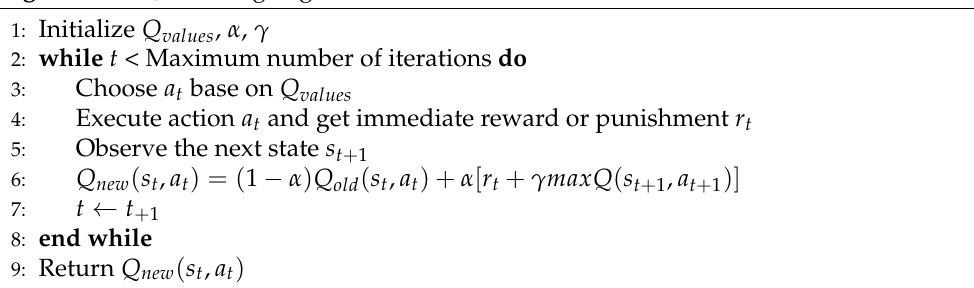
Algorithm 1 Q-Learning